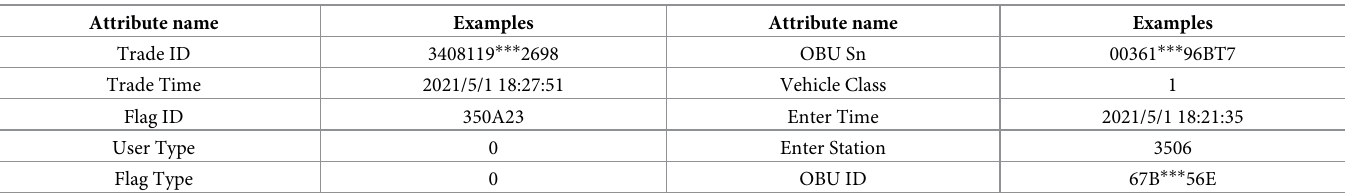
Table 1. ETC gantry system partial transaction data attribute table.